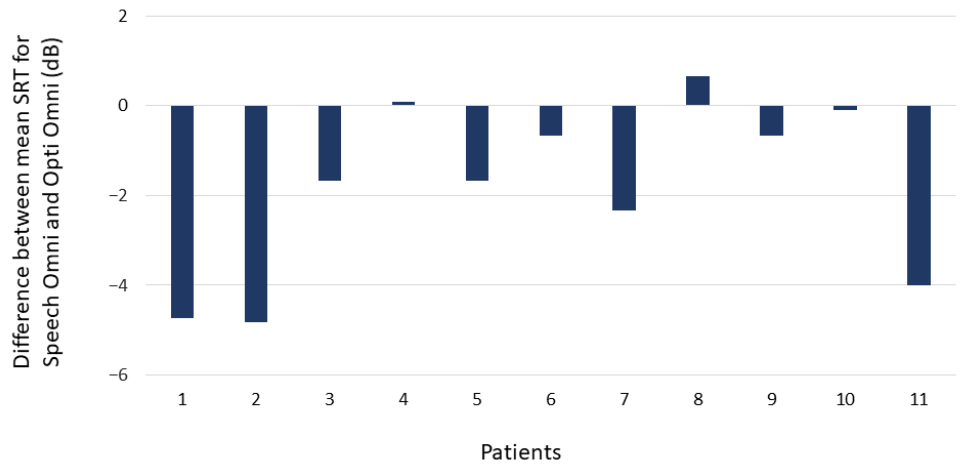
Figure 3. Difference between mean SRT (50% correct) for Opti Omni and Speech Omni for each of the 11 participants. A negative value indicates better scores with Speech Omni than with Opti Omni.